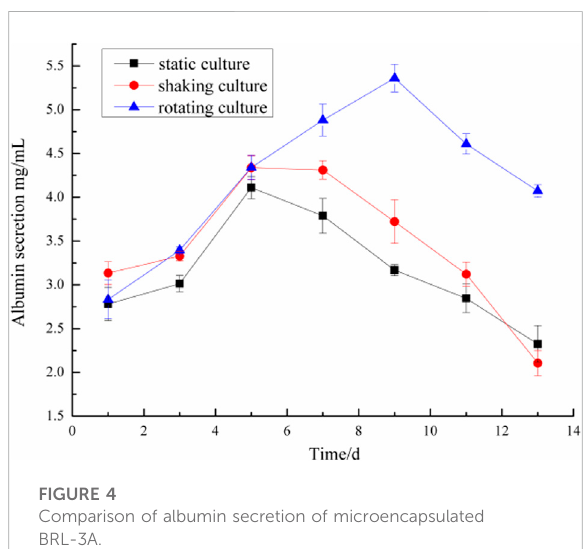
FIGURE 4 Comparison of albumin secretion of microencapsulated